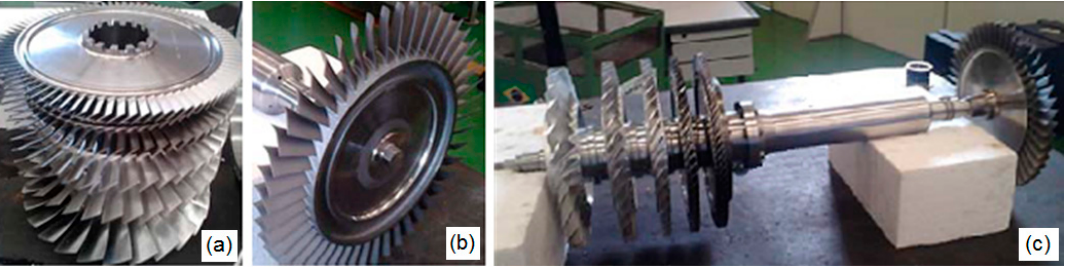
Figure 2. Rotating assembly of the aeronautical gas turbine with its compressor and turbine discs: ( a ) Compressor discs; ( b ) Turbine disc; ( c ) All rotating assembly.